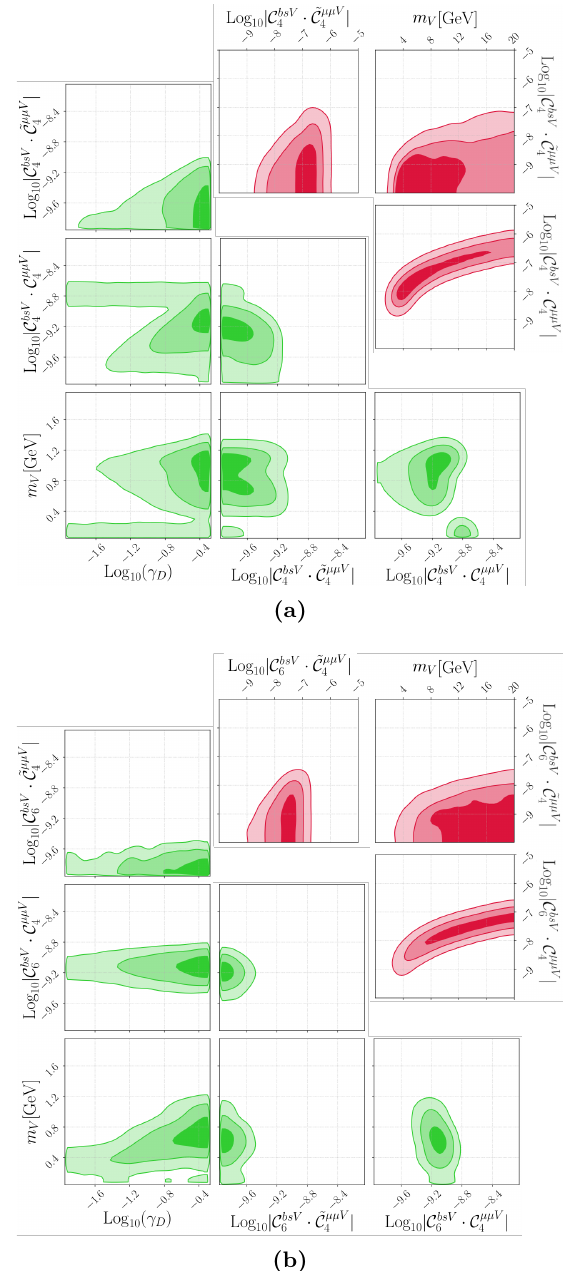
Figure 1. (a) Inference of model parameters from a fit to b → s anomalous data for the DEFT operators of dimension 4 in both the b − s and µ − µ currents ( 44 model). (b) Same for DEFT operator of dimension 6 in the b − s current and dimension 4 in µ − µ ( 64 model). The plots in red are relative to the high-mass fits (see main text) while the ones in green are relative to the low-mass ones, with the contours corresponding to the smallest regions of 68%, 95%, 99.7% probability. We refer to the main text for the sign of the couplings. Note that in (b) the coupling C bsV in units of GeV − 2